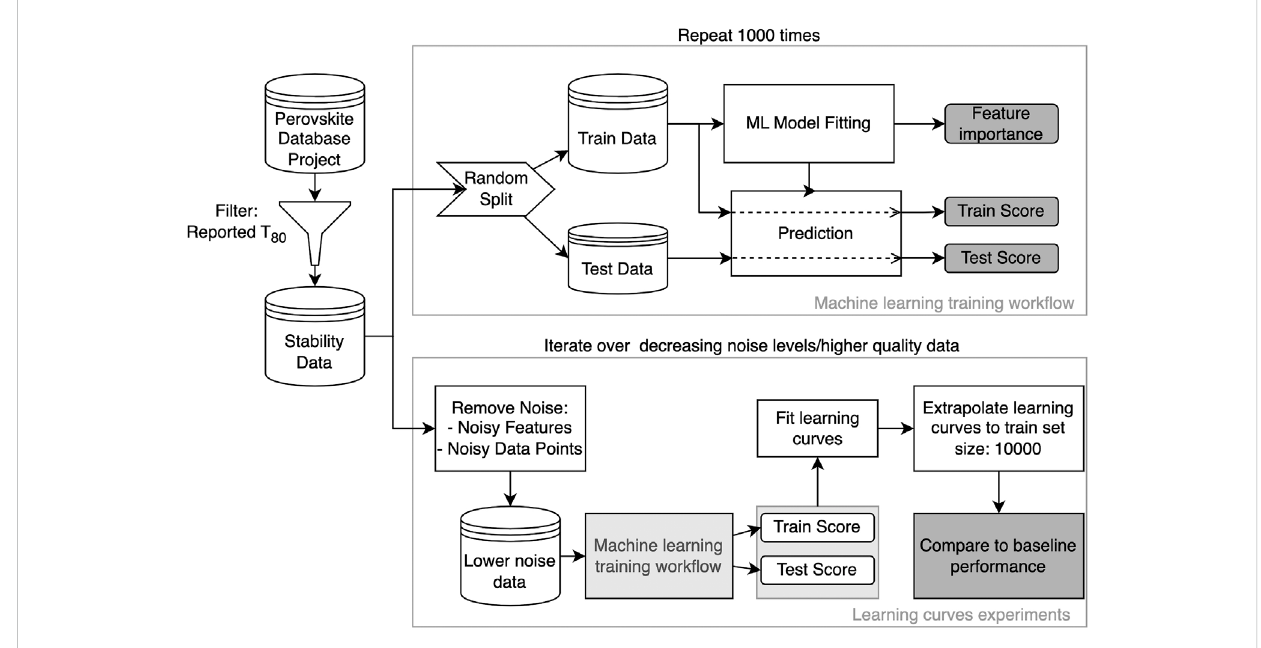
FIGURE 3 Schematic representation of the experiments performed.